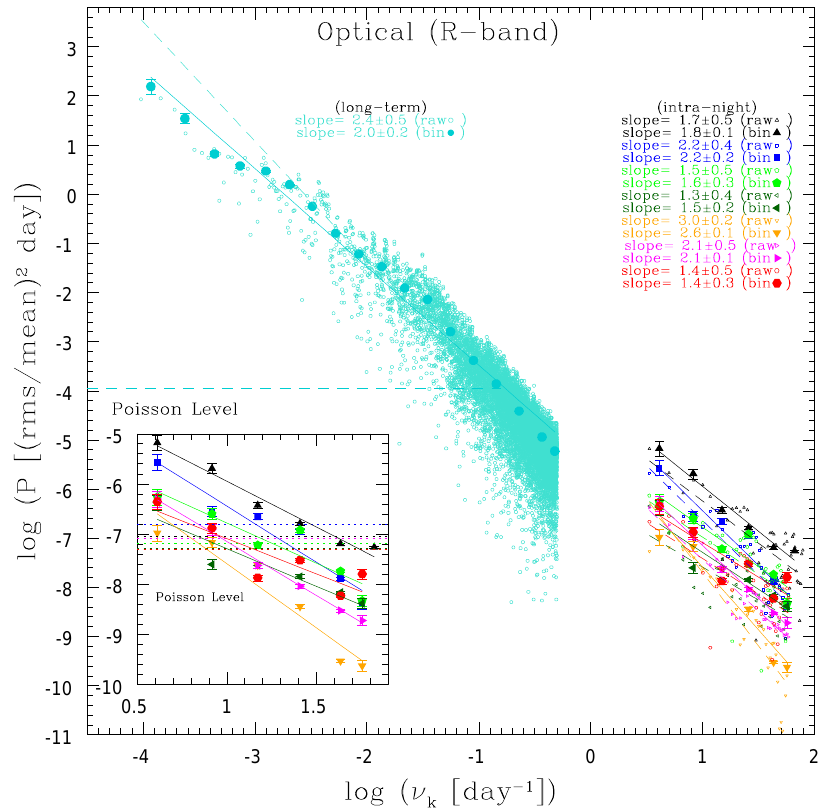
Figure 2. Composite (LTV+INV optical R-band PSD of PKS 0735 + 178. Long-term optical data were obtained with typical nightly sampling, while the densely-sampled intra-night data were obtained with 10–20min binning, depending on the source brightness and the sky transparency. Empty and filled symbols show the raw and binned periodogram estimates, respectively, while the dashed horizontal line shows the Poisson noise level due to measurement uncertainty achieved in these observations. Note that R-band PSD includes PSDs drawn using intra-night light curves when confirmed INV was seen (not shown here, see Table 1 of Goyal et al., 2016, submitted). Turquoise shows long-term flux measurements (Figure 3b), while red (10-12-04), magenta (23-12-04), orange (05-01-05), dark green (09-01-05), green (15-12-07), blue (07-01-13), and black (23-12-13) show INV PSDs (epoch of monitoring is given in the parentheses: dd-mm-yy). Inset plot shows the zoomed-in bin INV PSDs for better